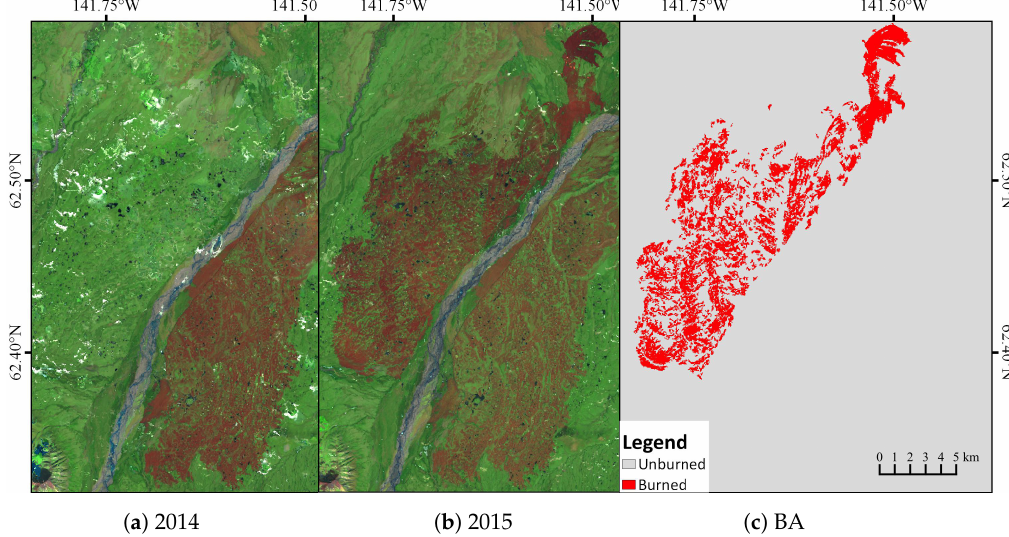
Figure 6. Burned area map example in Canada. ( a ) is the annually-composited Landsat images of 2014 with the minimum NBR values; ( b ) is the annually-composited Landsat images of 2015; ( c ) shows the detected burned scars occurred in